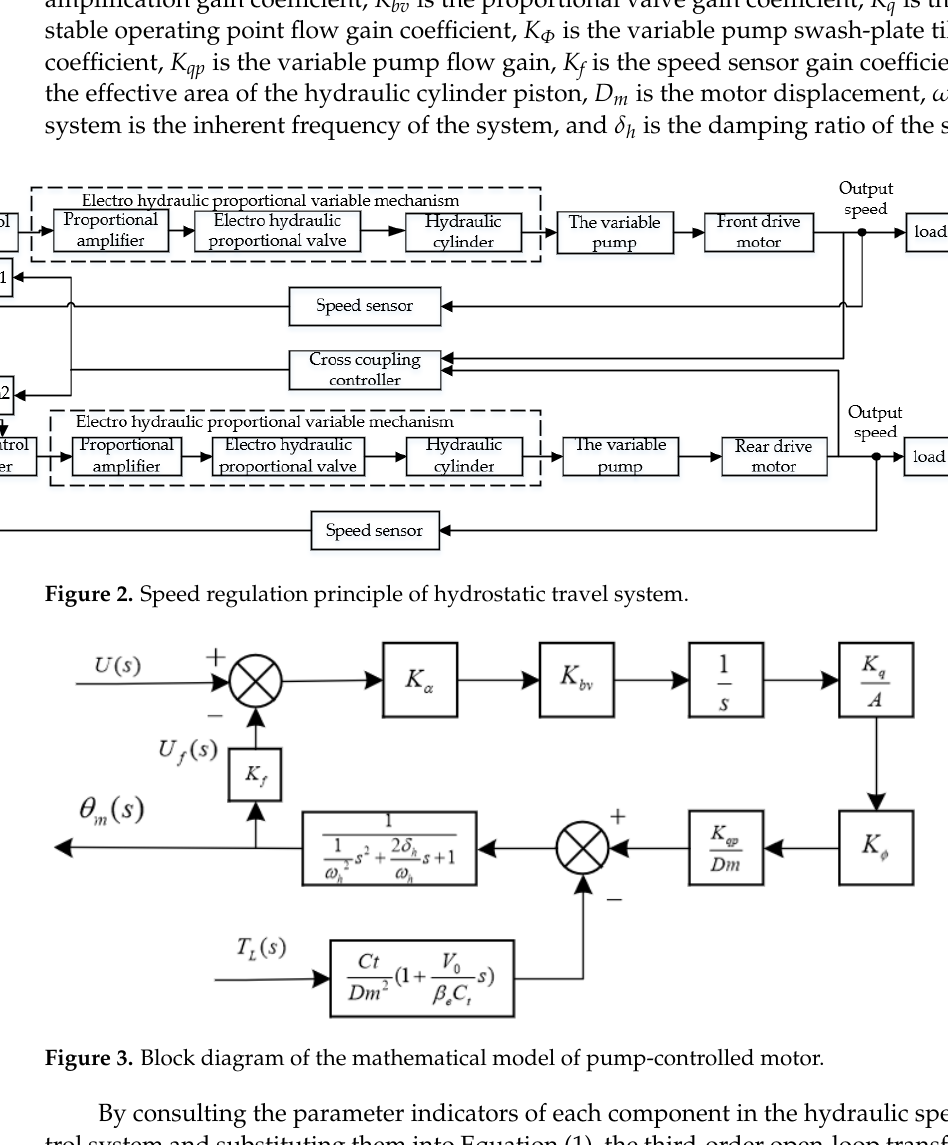
Figure 2. Speed regulation principle of hydrostatic travel system.